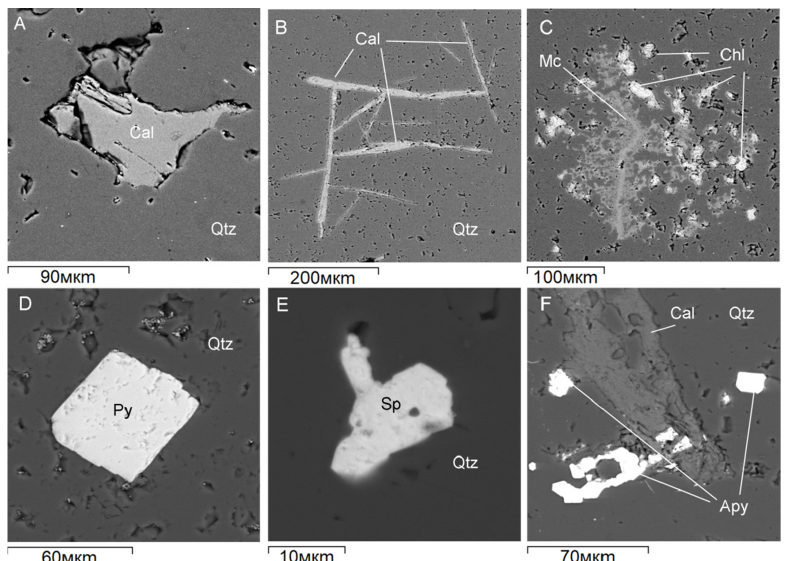
Figure 7. BSE images of micro-inclusions in black Onega agates: ( A ) calcite inclusion in the white area of the concentrically zoning agate, ( B ) calcite (Cal) inclusions in the black marginal area of quartzine spherolithe in spherulitic agate, ( C ) microcline (MC) and chlorite (Chl) in the white area of spherulitic agates, ( D ) prysmatic pyrite (Py) crystals in the colourless area of moss agate, ( E ) sphalerite (Sp) crystal in moss agate, and ( F ) quartz (Qtz) fissure filled by calcite, and accumulations of arsenopyrite (Apy) crystals in spherulitic agate.